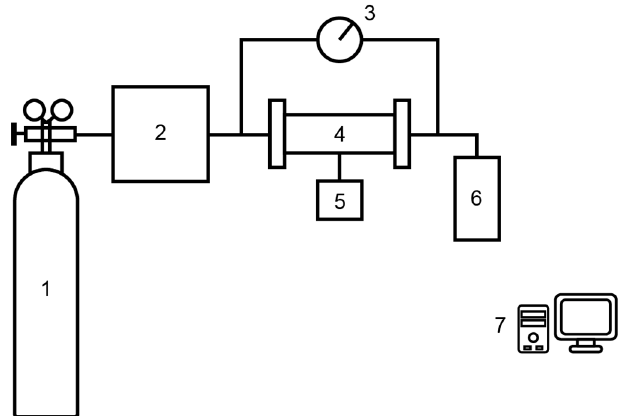
Figure 3. Schematic of the apparatus used for the stress-dependent permeability experiment: 1, High-pressure gas source; 2, Pressure control panel; 3, Pressure sensor; 4, Core holder; 5, Hand pump; 6, Measuring cylinder; and 7, Data acquisition system.